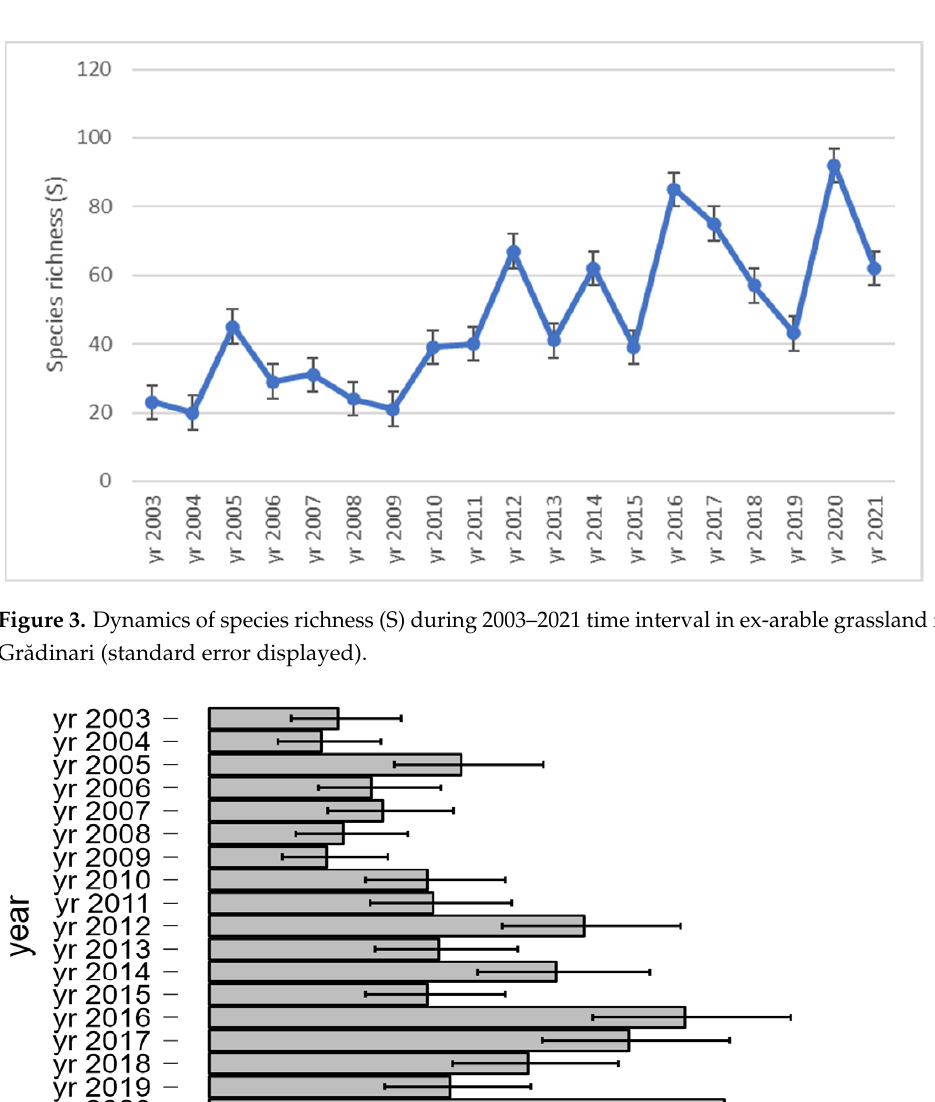
Figure 3. Dynamics of species richness (S) during 2003–2021 time interval in ex-arable grassland from Gr ă dinari (standard error displayed).